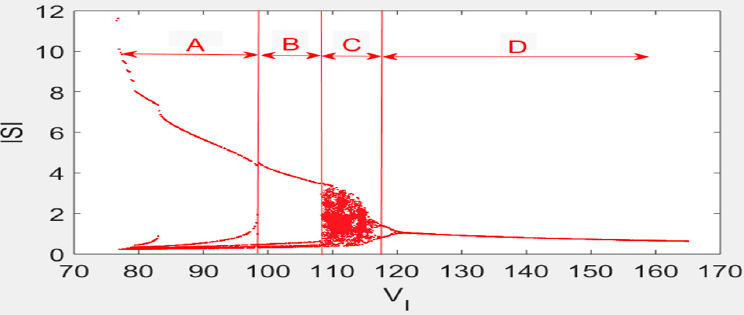
Figure 1. Inter-spike interval bifurcation diagram versus the parameter V I .